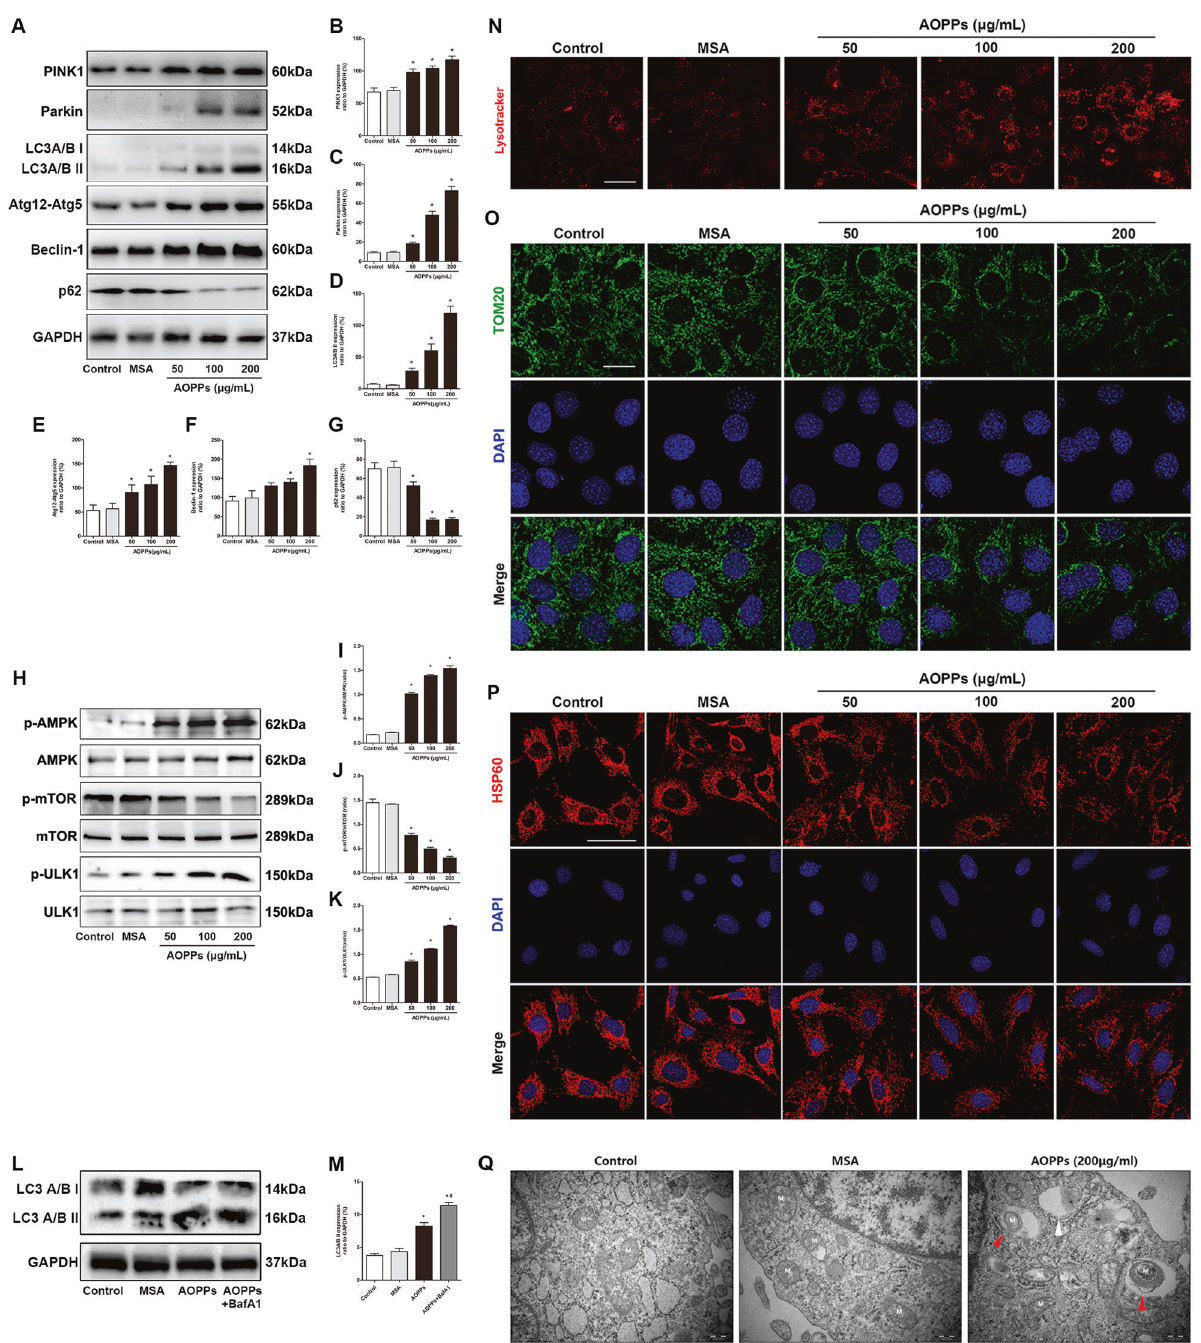
Fig. 2 AOPPs induced mitophagy in MCET3-E1 cells. A – G AOPP treatment signi fi cantly increased PINK1, Parkin, LC3A/B-II, Atg12-Atg5, and Beclin-1 expression while decreasing p62 expression in a concentration-dependent manner. H – K AOPP treatment signi fi cantly increased the phosphorylation of AMPK and ULK1 but inhibited the phosphorylation of mTOR in a concentration-dependent manner. L , M The expression level of LC3A/B-II in AOPPs + BafA1 was signi fi cantly higher than AOPPs group. N Representative confocal microscope images using LysoTracker Red revealed that AOPPs induced lysosome generation in MC3T3-E1 cells in a concentration-dependent manner (scale bar = 20 μ m). O Representative confocal microscope images showed that AOPPs induced TOM20 degradation in a concentration-dependent manner (scale bar = 20 μ m). P Representative confocal microscope images showed that AOPPs induced HSP60 degradation in a concentration-dependent manner (scale bar = 50 μ m). Q Representative TEM images showing autophagosomes (white arrow) and mitophagy (red arrow, M: mitochondria) in MC3T3-E1 cells after AOPP treatment (scale bar = 500 nm). All experiments were repeated for at least three times. Data are presented as the mean ± SD. * P < 0.05 versus control.